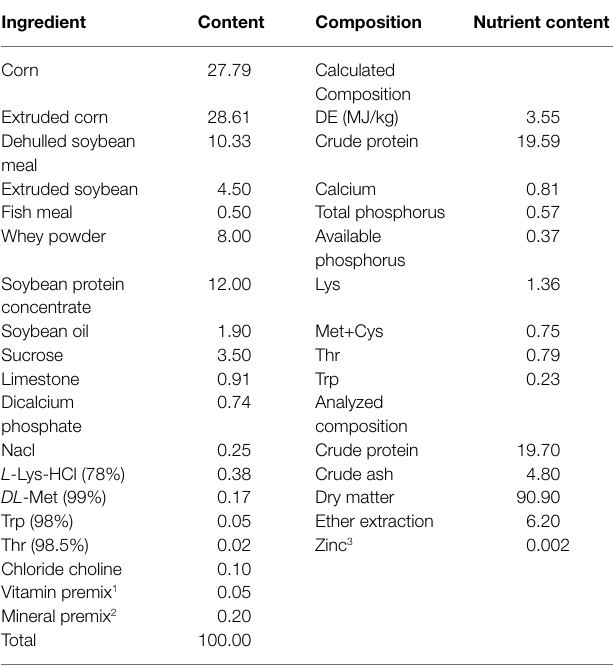
TABLE 1 | Composition and nutrient level of basic diet (air dry basis